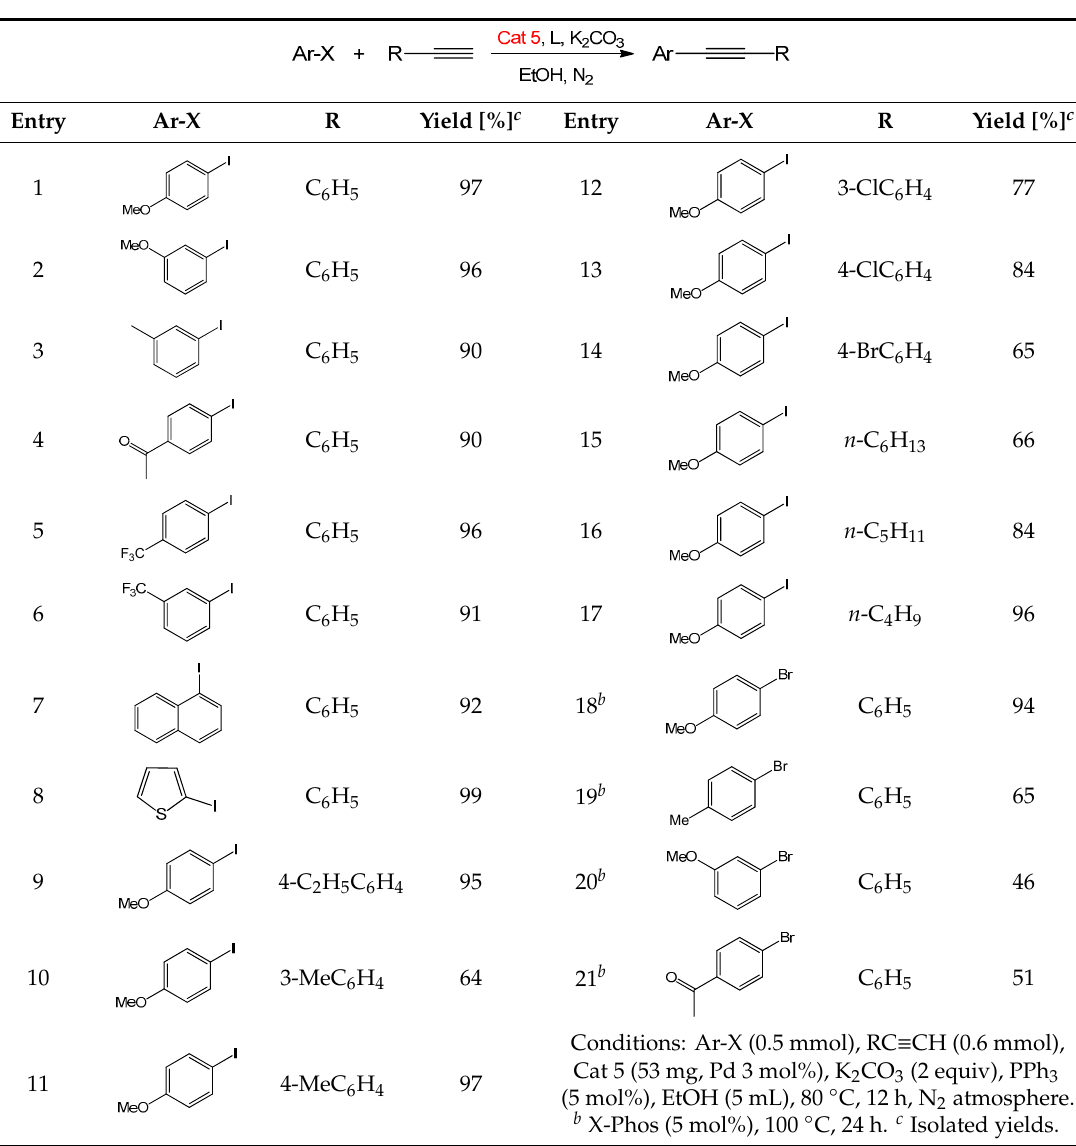
Table 2. Sonogashira cross-coupling of aryl halides and terminal alkynes catalyzed by Pd/Cu@AC.